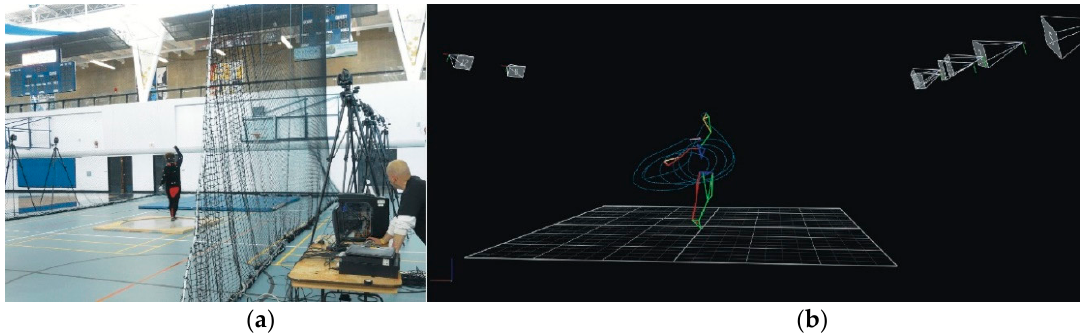
Figure 1. The 3D motion capture of hammer throw. ( a ) The set-up of the data collection; ( b ) a sample of the 3D data.